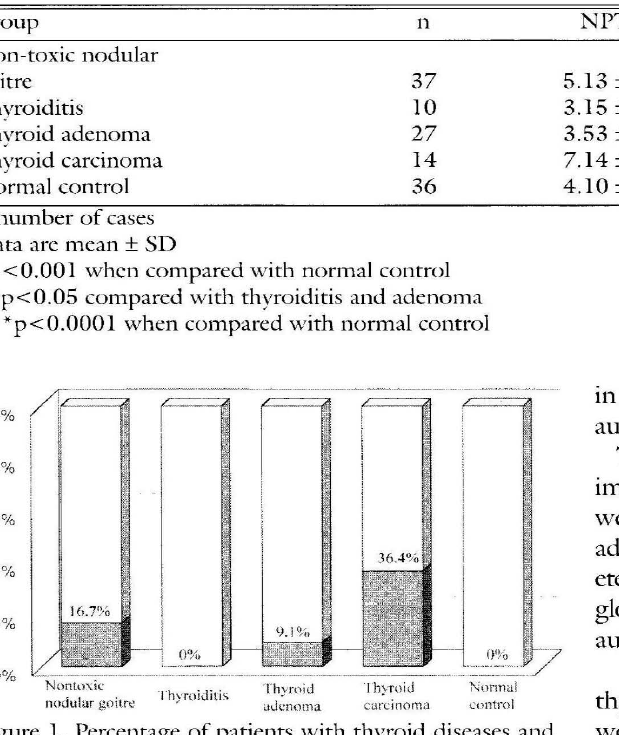
Table 1. Serum levels of neopterin (NPT) and interleukin-6 (IL-6) in patients with thyroid diseases and in normal controls